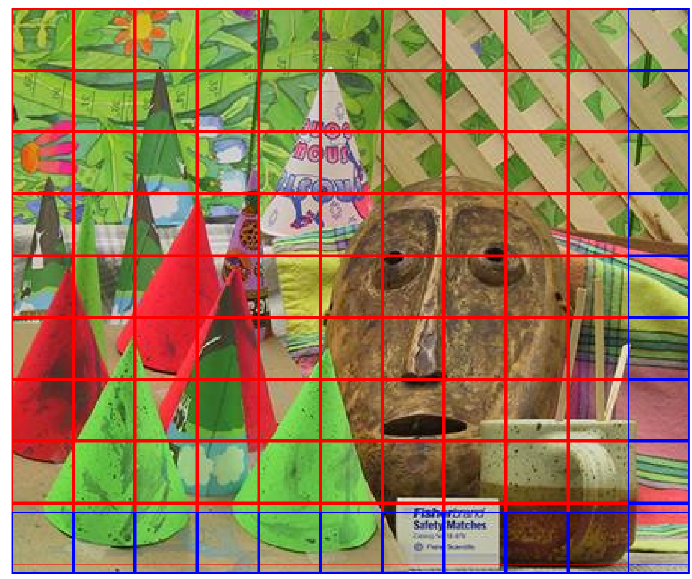
Figure 2. Example of blocking schema employed in